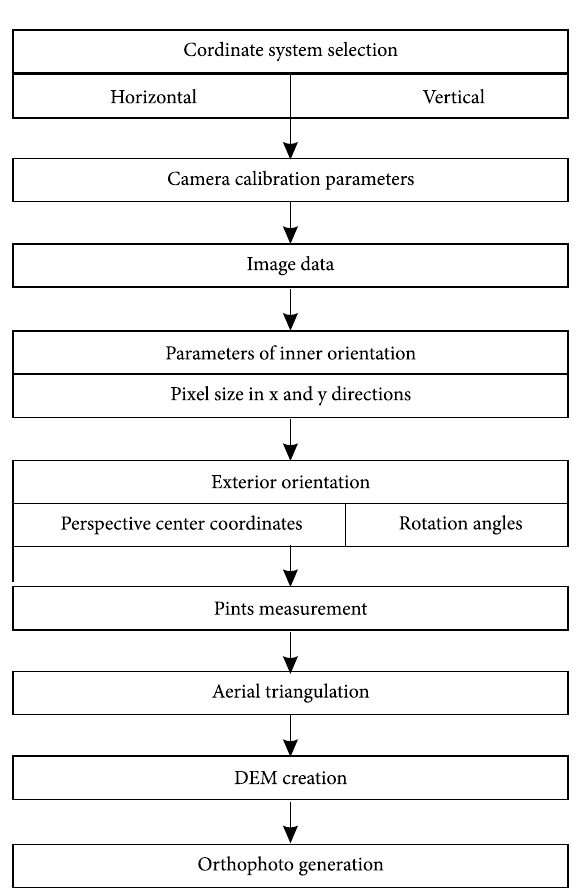
Fig. 2. General workflows on